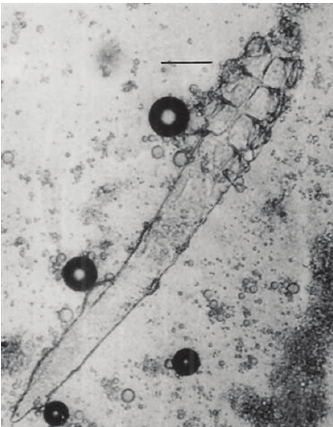
Figure 5: Demodex ghanensis mite in infected material extracted from meibomian gland lesions of demodectic mange in a cow. 20% potassium hydroxide solution. Scale bar: 50 𝜇 m.